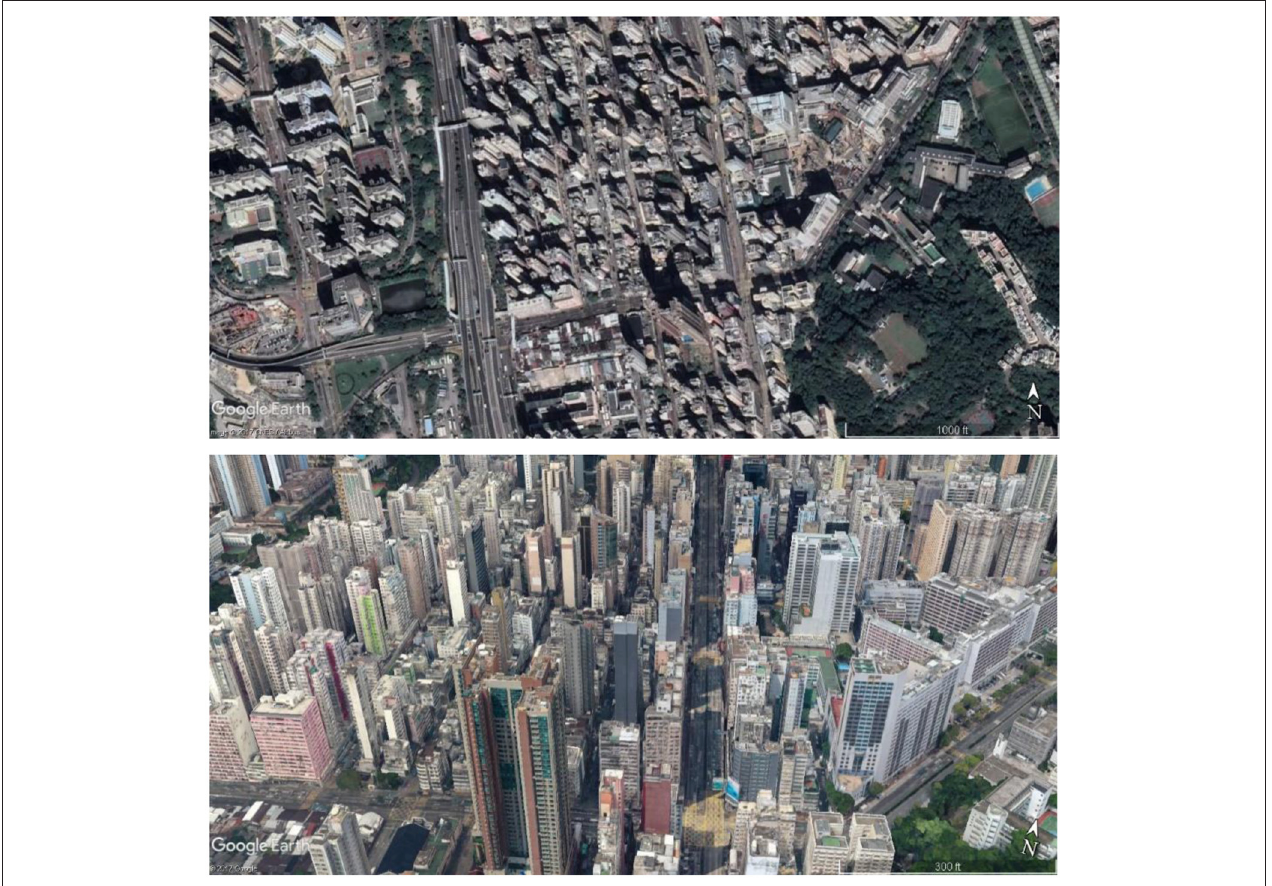
FIGURE 1 | We investigated urban alleys in the Yau Tsim Mong District in the central area of Hong Kong City (Image: Google Earth Pro).